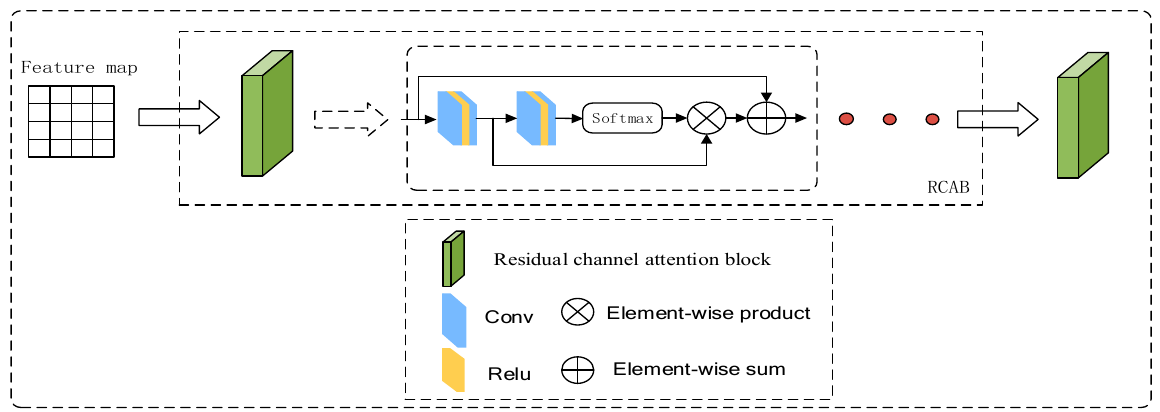
Figure 4. Multi-residual channel attention block.